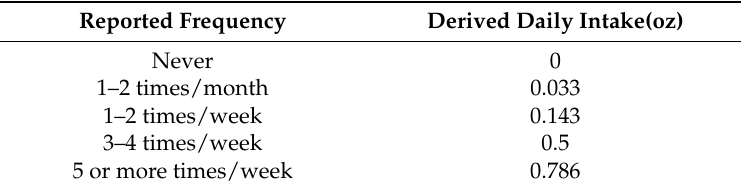
Table 1. Food and beverage responses and conversion to frequency of derived daily